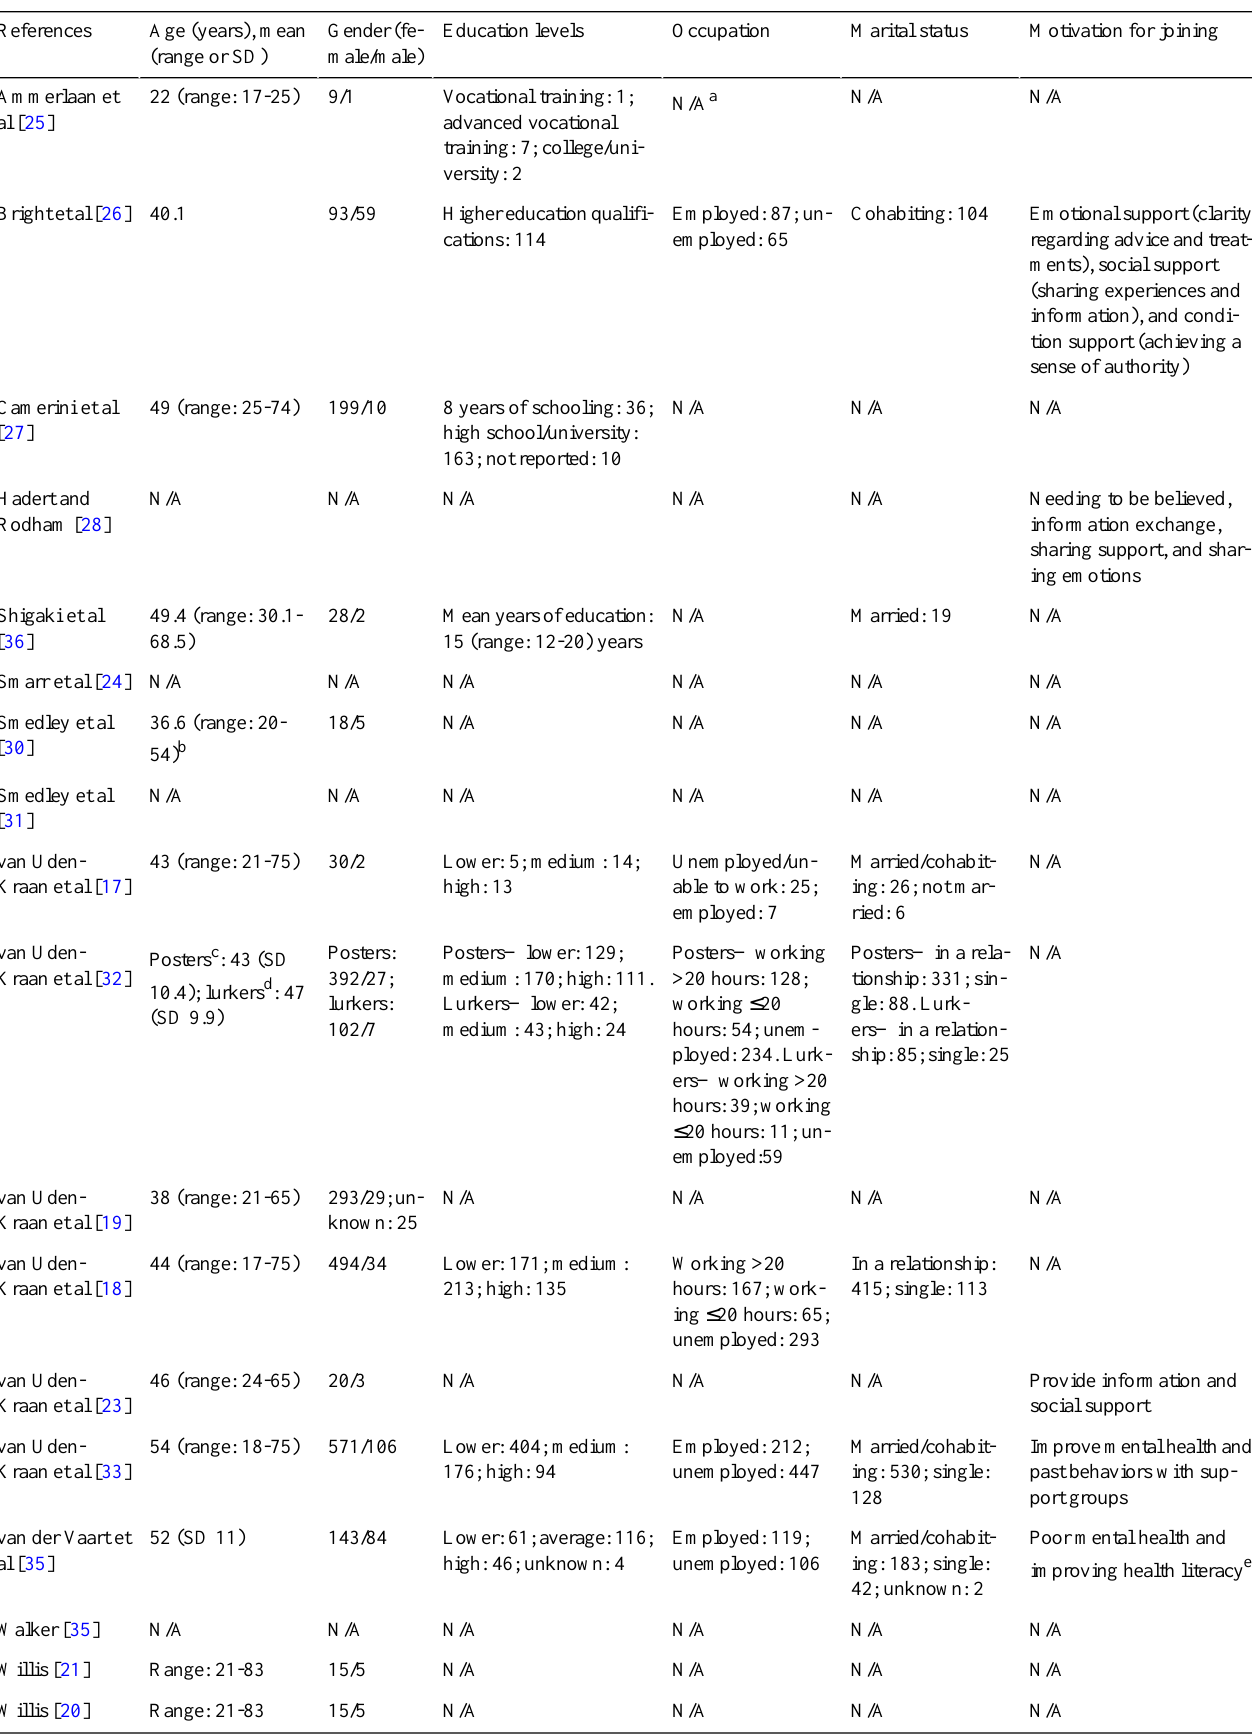
Table 3. Characteristics of online support group